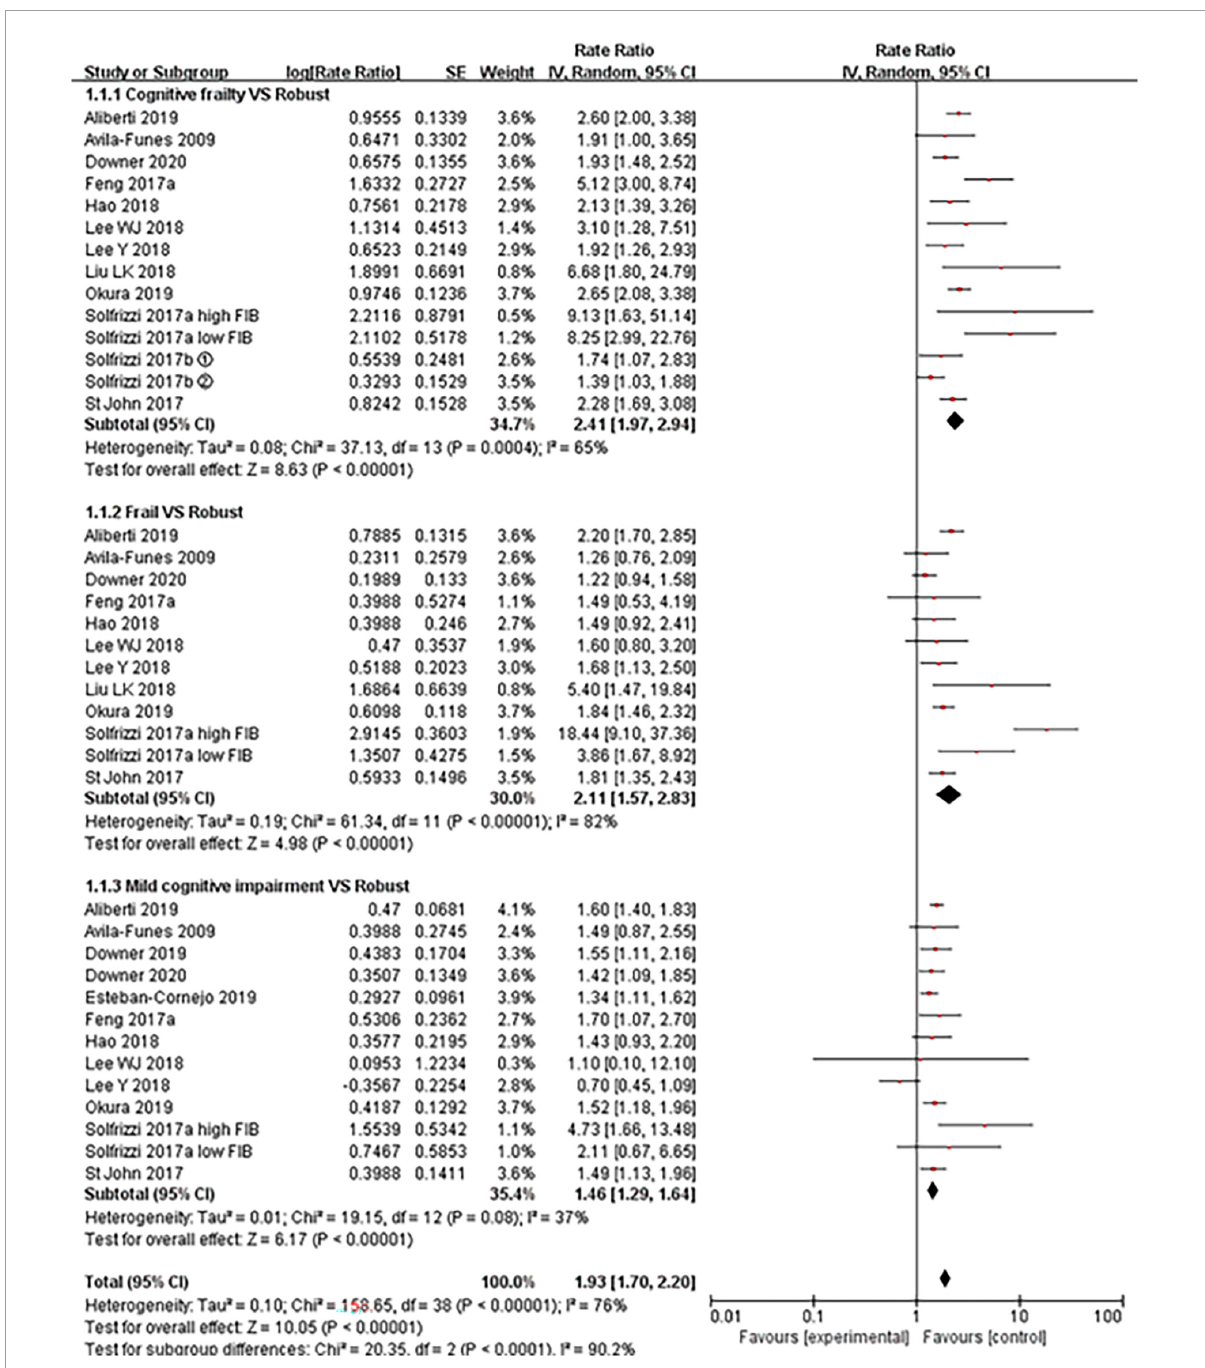
FIGURE2 Forest plot of the association between cognitive frailty, frailty, and mild cognitive impairment and mortality in older adults (reference group: participants were free of frailty and mild cognitive impairment), using random-effects meta-analysis. (cid:192) : follow-up 3.5 years; (cid:193) : follow-up 7 years; 95% CI, 95% confidence interval; high FIB, high fibrinogen (inflammatory); low FIB, low fibrinogen